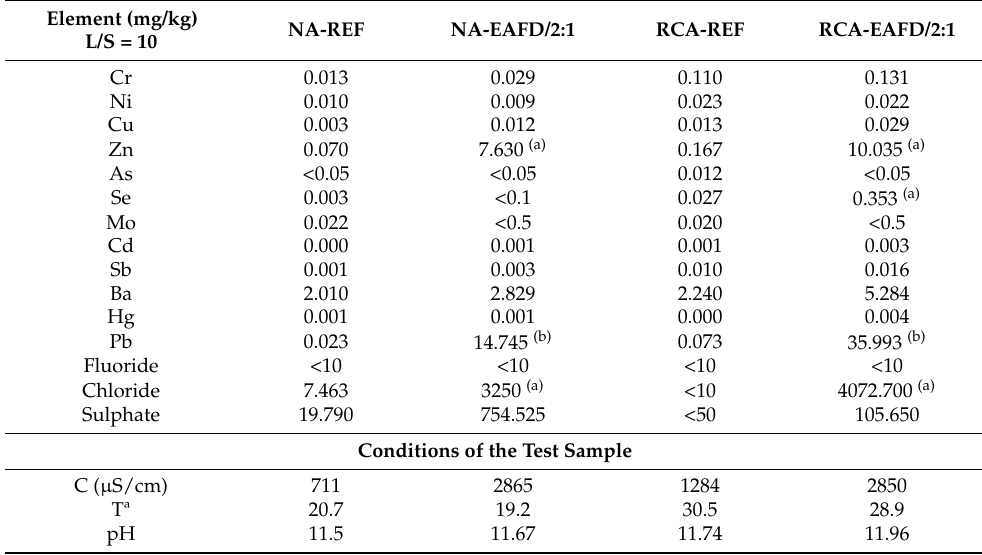
Table 7. Leaching behavior of monolithic samples of mortar (XP